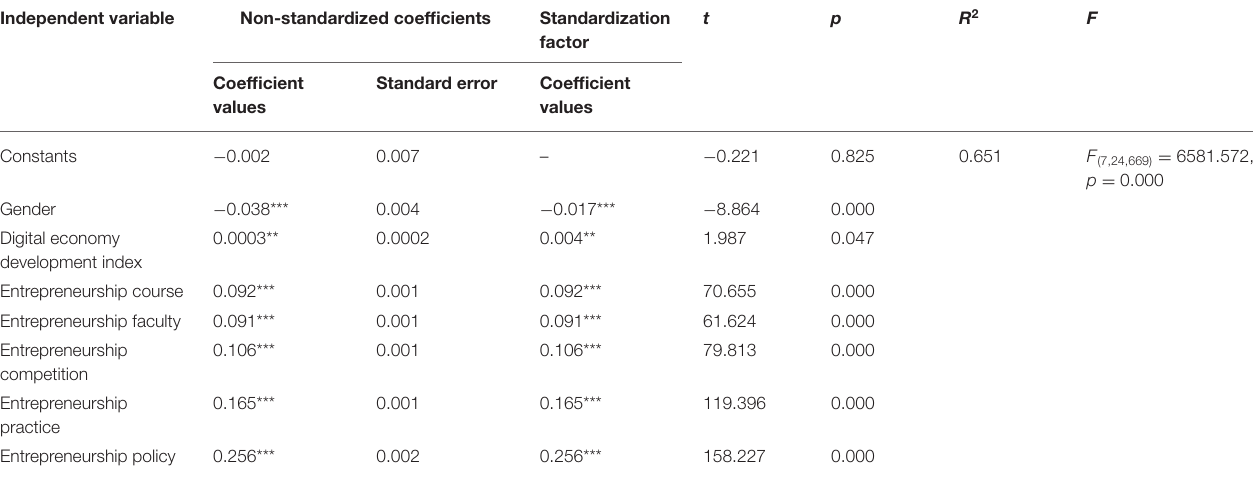
TABLE 4 | Results of the ridge regression analysis. Independent